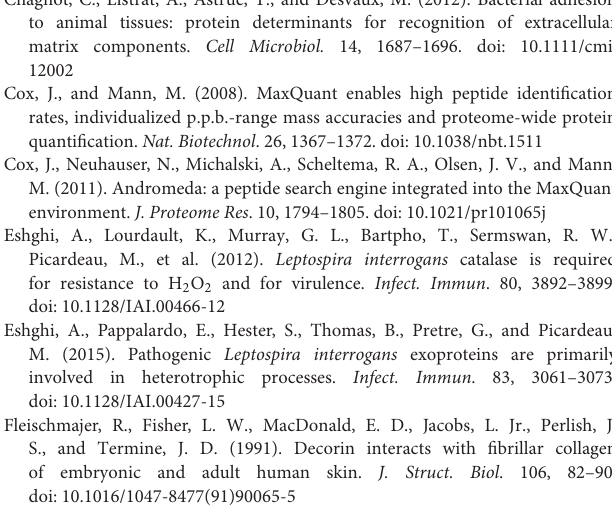
Supplementary Table 1 | Identification of proteins in LPF and Patoc I strains by in solution tripsin digestion and LC-MS-MS analysis. Supplementary Table 2 | Proteins identified only in the LPF strain. Supplementary Table 3 | Proteins identified only in the Patoc I strain. Supplementary Table 4 | Proteins identified in the supernatants of both LPF and Patoc I strains. Supplementary Table 5 | Putative moonlighting proteins identified in LPF and Patoc I culture